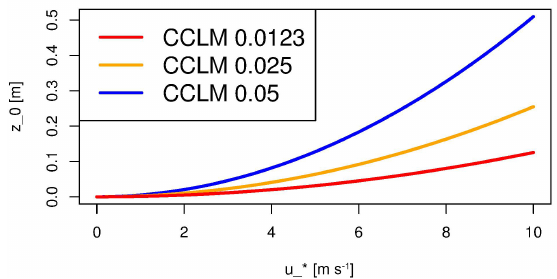
Figure 2. Roughness length as function of u ∗ for three values of Charnock parameter α